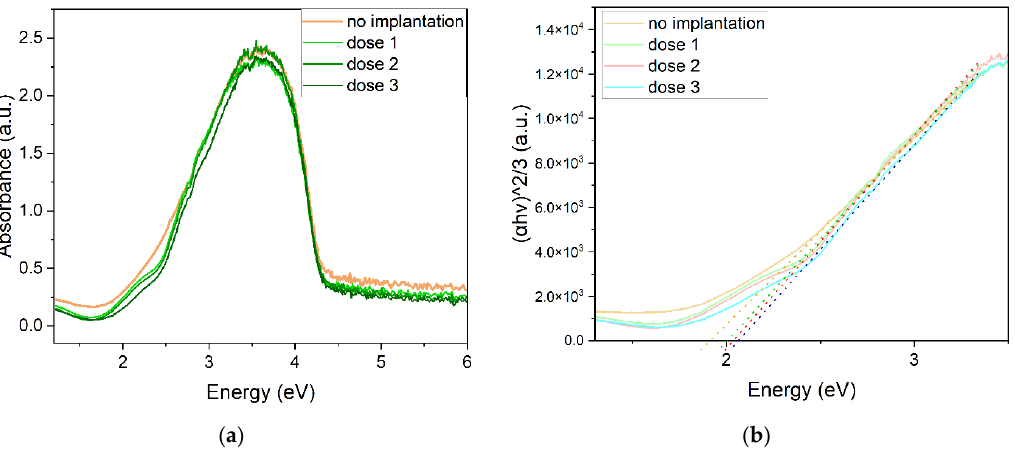
Figure 8 . ( a ) Absorbance of Cu 2 O thin films, ( b ) Tauc plot for Cu 2 O. Figure 8. ( a ) Absorbance of Cu 2 O thin films, ( b ) Tauc plot for Cu 2 O. A Tauc plot was created for a direct forbidden transition ( γ = 3/2). From this method, the calculated energy band gaps are: 1.91 eV, 2.00 eV, 2.04 eV, and 2.06 eV for non- implanted, dose 1, dose 2, and dose 3 samples, respectively. The optical energy band gap increases with the dose of implanted ions. For implanted samples, an envelope is seen around 2 eV, which may indicate another transition occurring in the material. In the case of the non-implanted sample, this effect is not observed (Figure 8b).